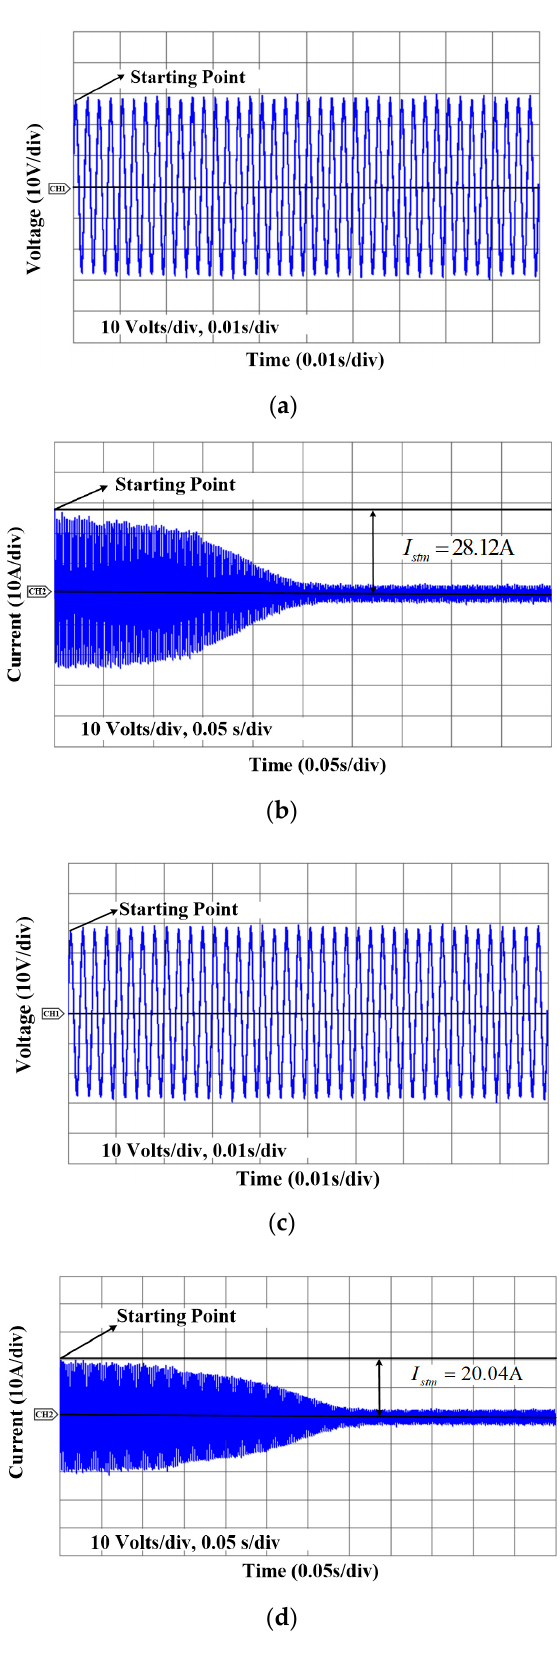
Figure 11. The experimental voltage and current comparison. ( a ) The voltage with the direct starting ( b ) The current with the direct starting. ( c ) The voltage with the series resistance starting. ( d ) The current with the series resistance starting.